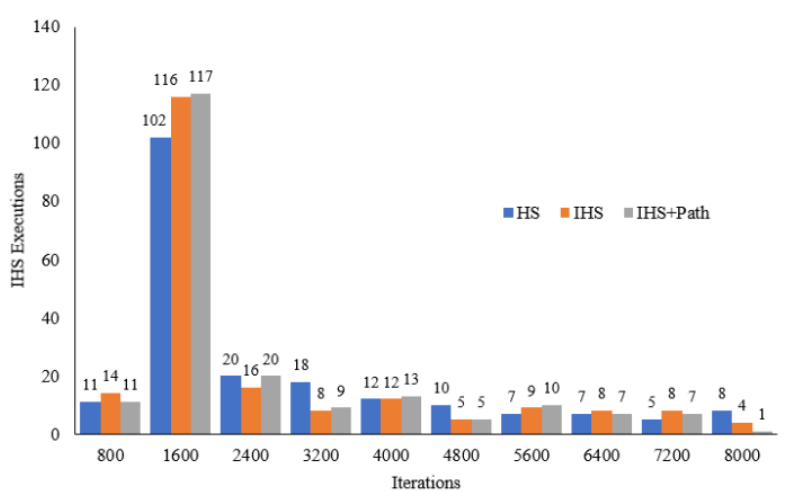
Figure 8. Convergence frequency of different algorithms for the 119-bus test system.